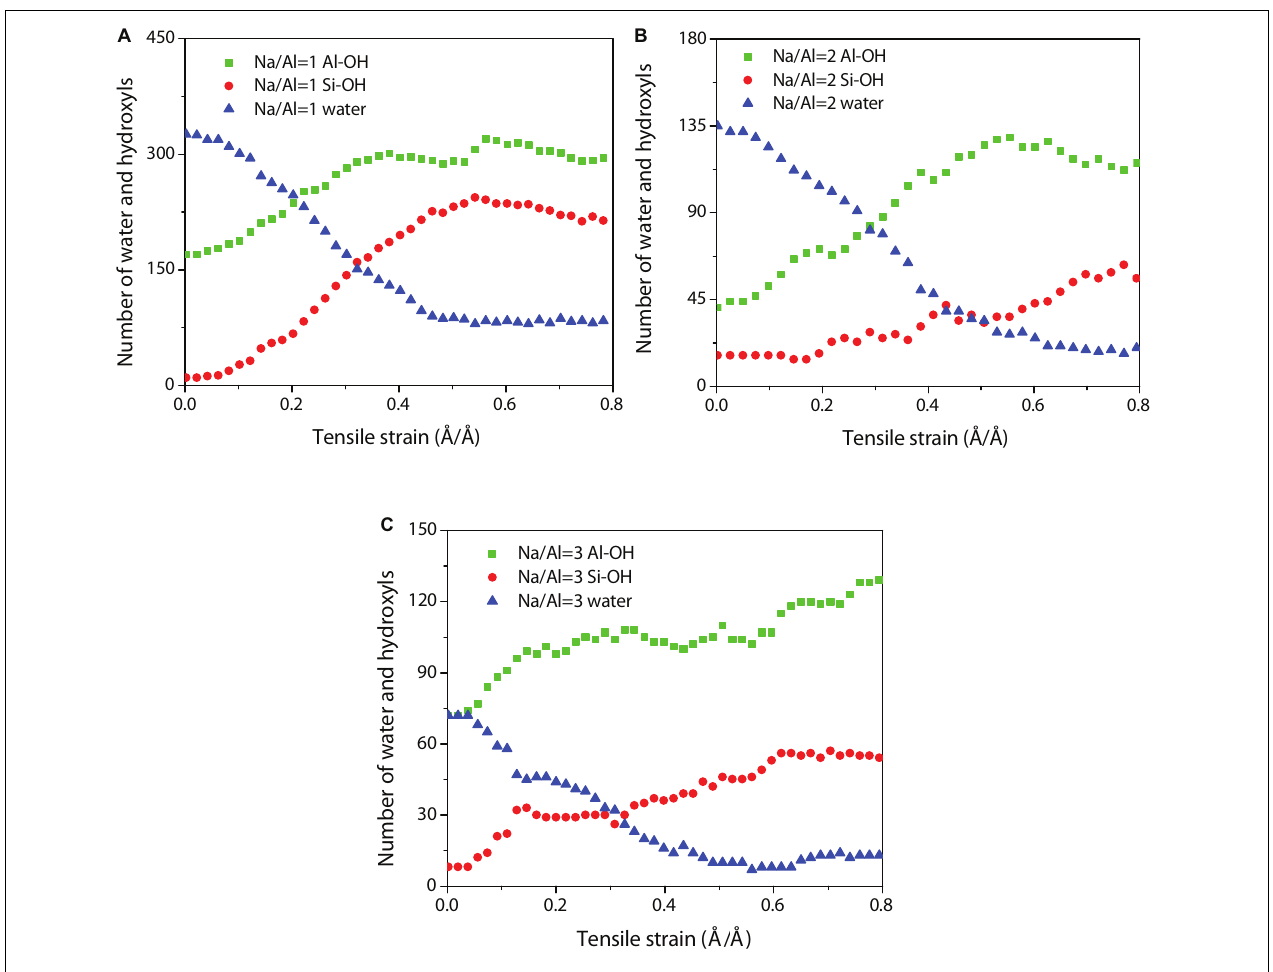
FIGURE 8 | Evolution of the number of water molecules and hydroxyl as functions of strain with a Na/Al ratio of (A) 1, (B) 2, and (C) 3.